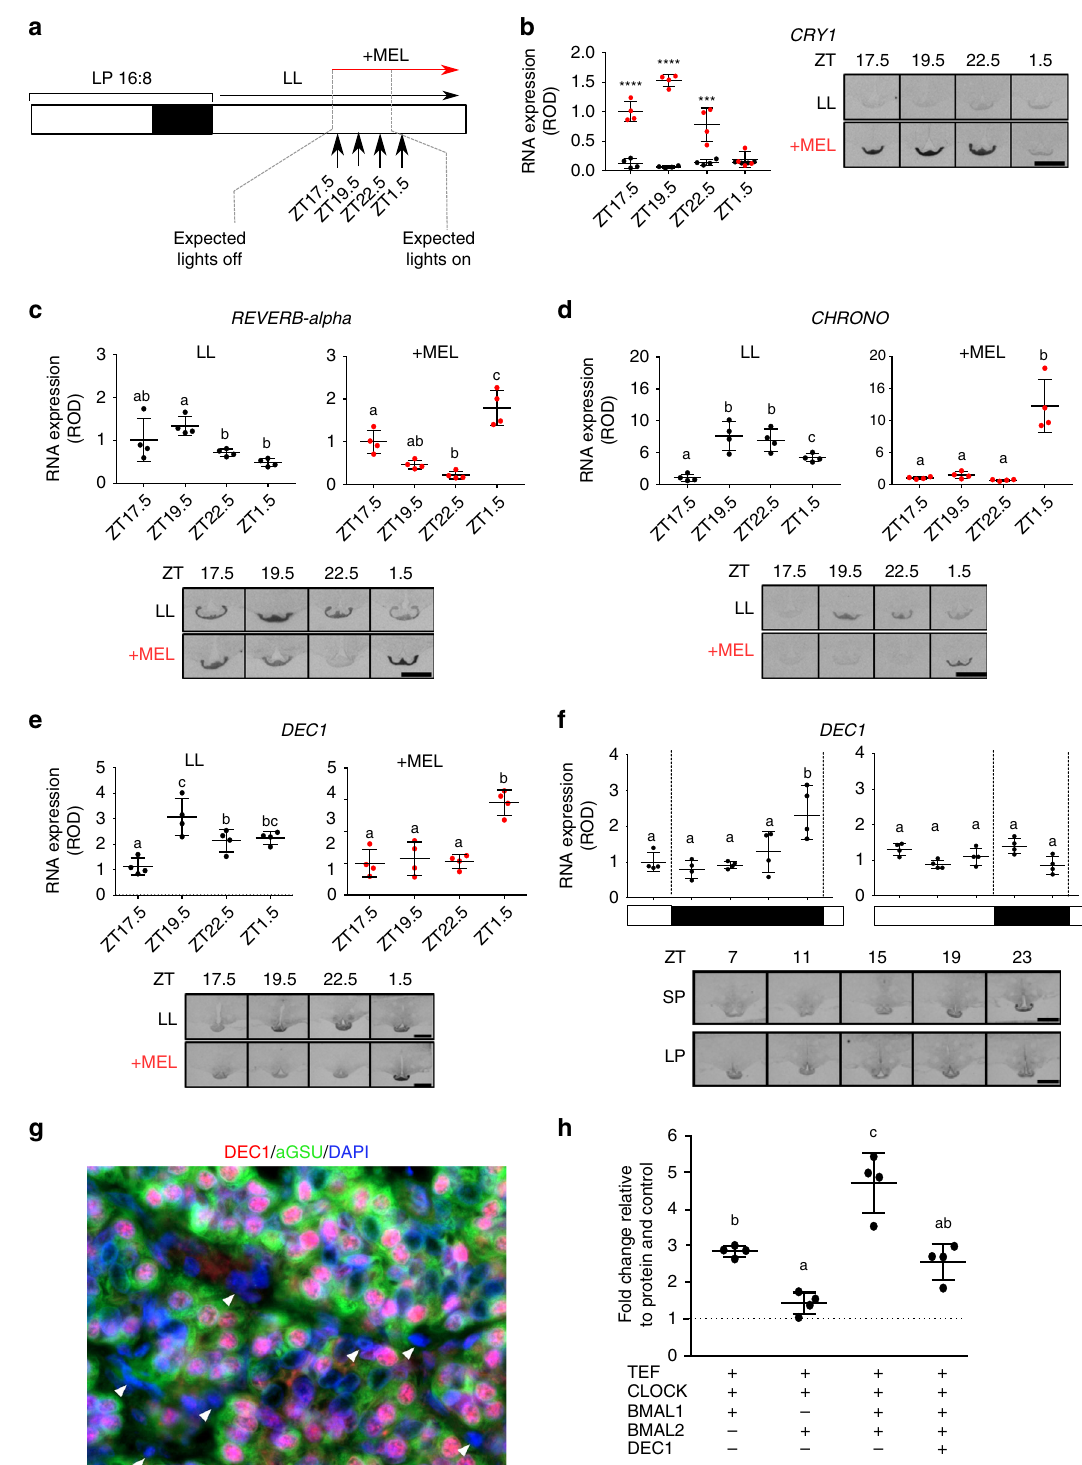
EYA3 is a particular example of this showing seasonal regulation of only one out of two transcription start sites, presumably sea- sonally modulating the transcription of EYA3 via BMAL2. On transfer to long photoperiods the EYA3 and TSH β locus show a progressive increase over a number of weeks in H3K4me3 marks matching the increase in expression (Fig. 2c, d). Our earlier work shows that at the individual cell level the transition between